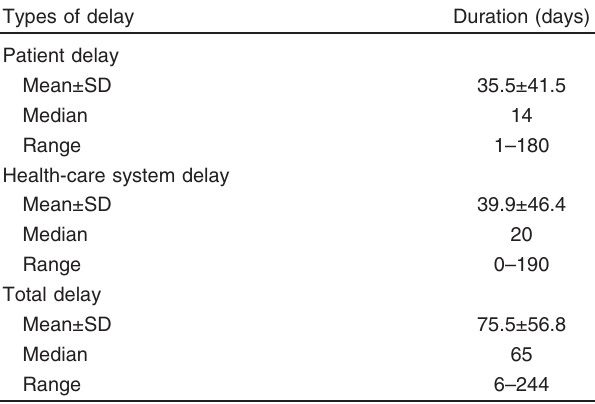
Table 6 Duration of different types of delay among studied patients ( N = 183) Types of delay